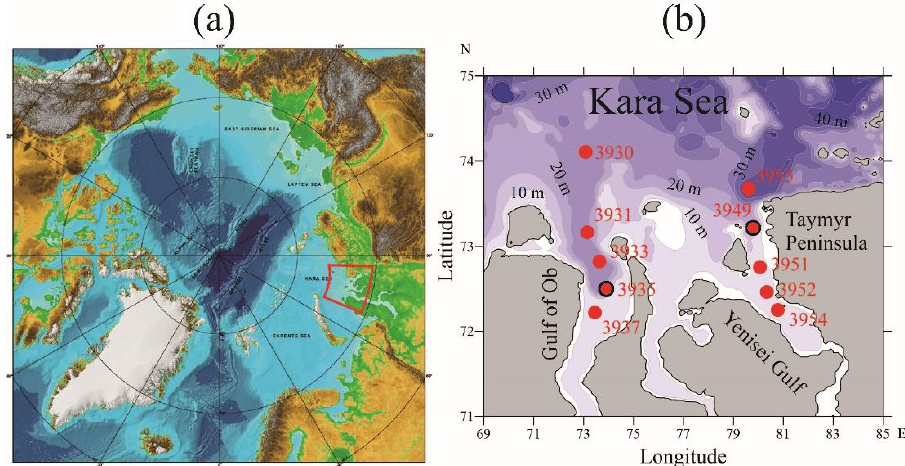
Figure 12. ( a ) IBCAO map of the Arctic Ocean; the red contour indicates the area of the field survey performed in the Kara Sea. ( b ) Bathymetry of the southern part of the Kara Sea; red circles indicate the locations of vertical thermohaline profiling; red circles with black contours indicate locations of water sampling in the Gulf of Ob (station no. 3935) and the Yenisei Gulf (station no. 3949).